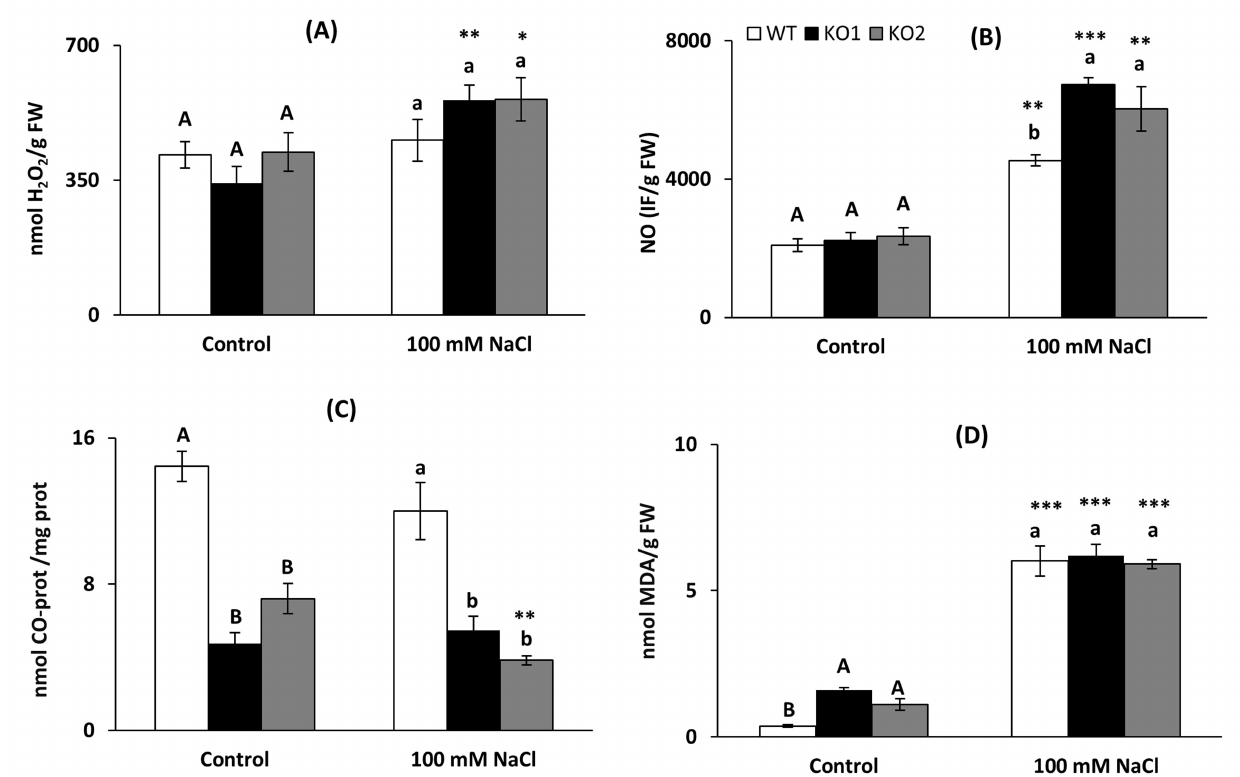
Figure 5. Oxidative stress markers. ( A ) Hydrogen peroxide, ( B ) nitric oxide (in arbitrary fluorescence units), ( C ) carbonyl (CO) proteins and ( D ) malondialdehyde (MDA) in leaves of A. thaliana wild type (WT) and two KO Attrxo1 mutant lines grown in the absence (Control) and presence of 100 mM of NaCl. Data per fresh weight (FW) or mg proteins (prot.) are the mean ± SE of at least three independent experiments. Different letters indicate significant differences ( p < 0.05) among genotypes in each condition according to the Tukey’s test, and the asterisks indicate significant differences of each genotype in salinity compared to the control condition using the t -Student’s test (*, **, *** at p < 0.05, p < 0.01 and p < 0.001,